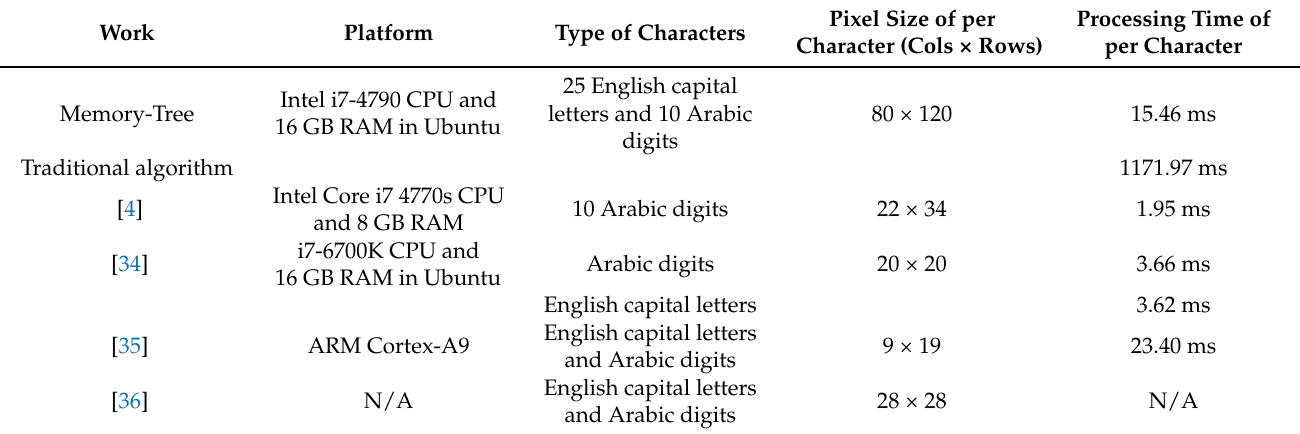
Table 3. Comparison with similar character recognition algorithms in software